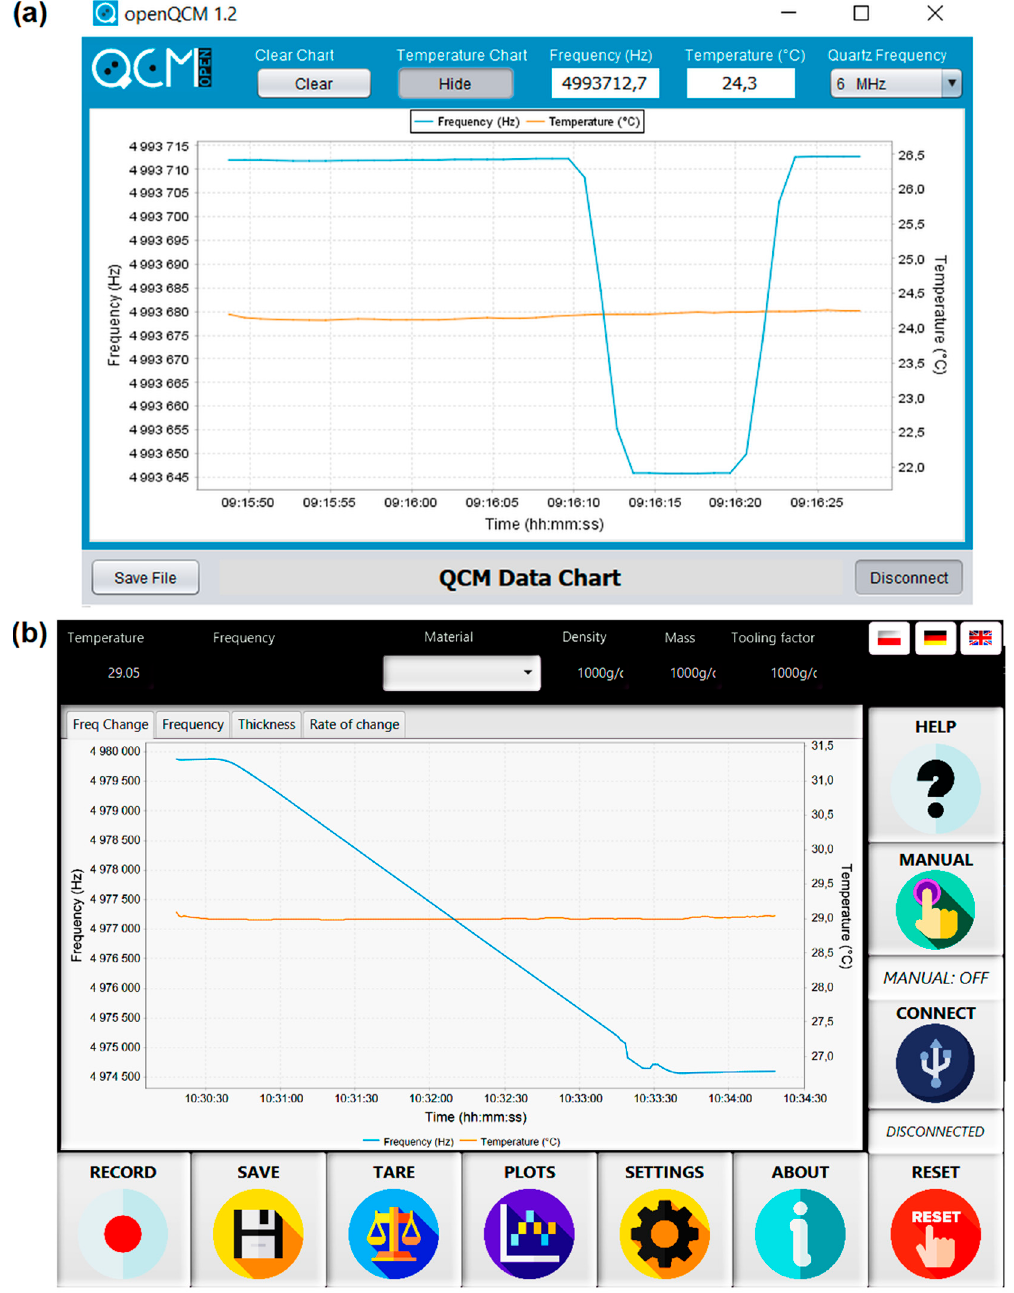
Figure 5. ( a ) OpenQCM application interface, ( b ) interface created for the purpose of this work, based on the same classes as interface ( a